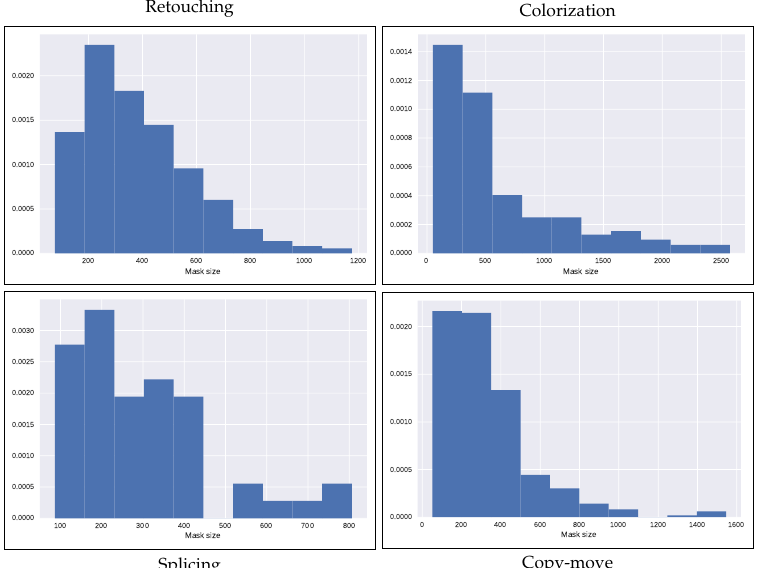
Figure 3. Distribution of the forgery size in each of the datasets considered. The forgery size is shown as the square root of the mask size, which represents the side of its equivalent